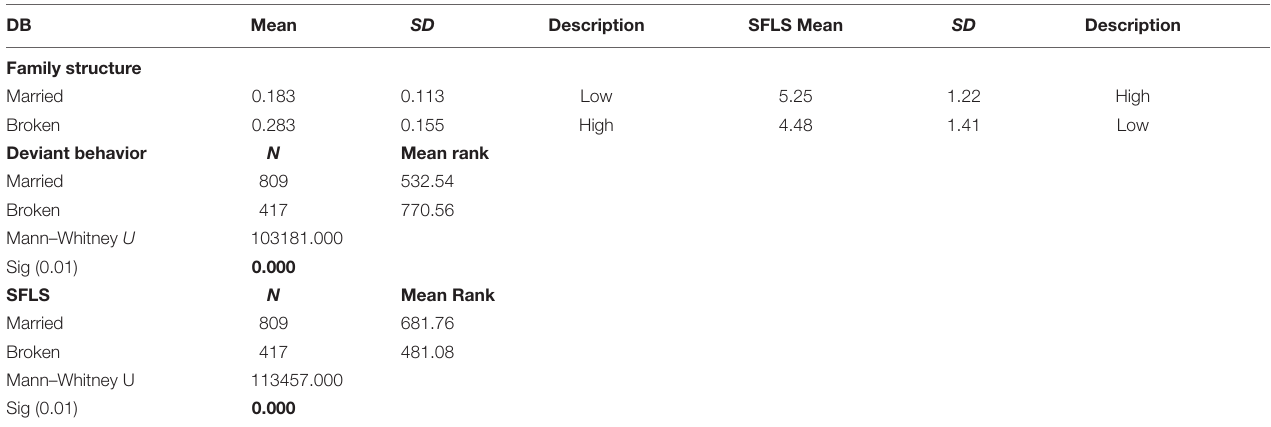
TABLE 4 | Mean of the deviant behavior and the family satisfaction in terms of family structure.